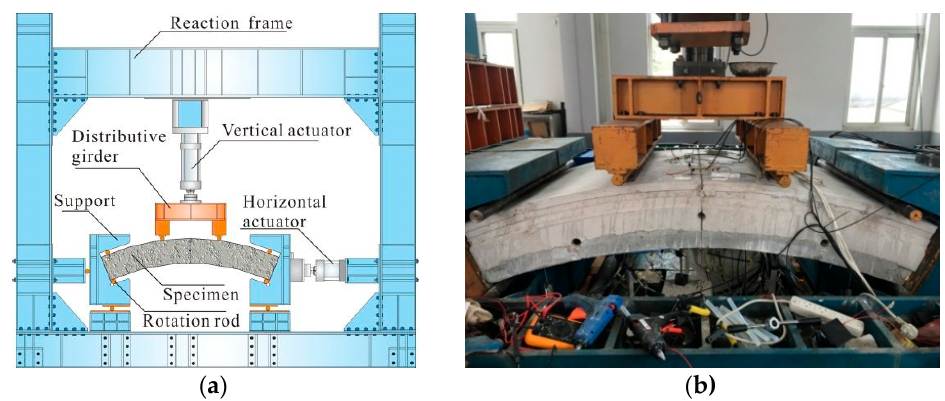
Figure 6. Setup of loading test. ( a ) Schematic diagram; ( b ) photo.